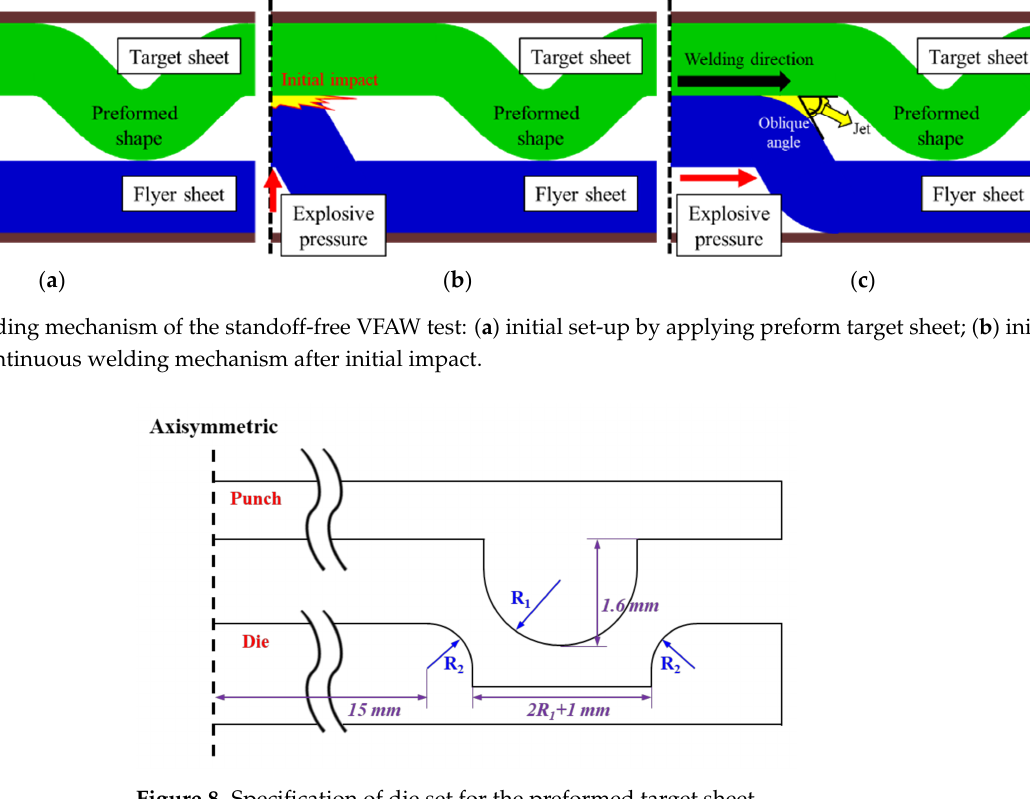
Figure 8. Specification of die set for the preformed target